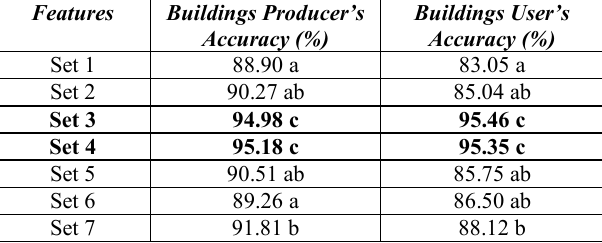
Table 6. Comparison of mean values of producer’s and user’s accuracies for “buildings” class and the seven sets of features tested.